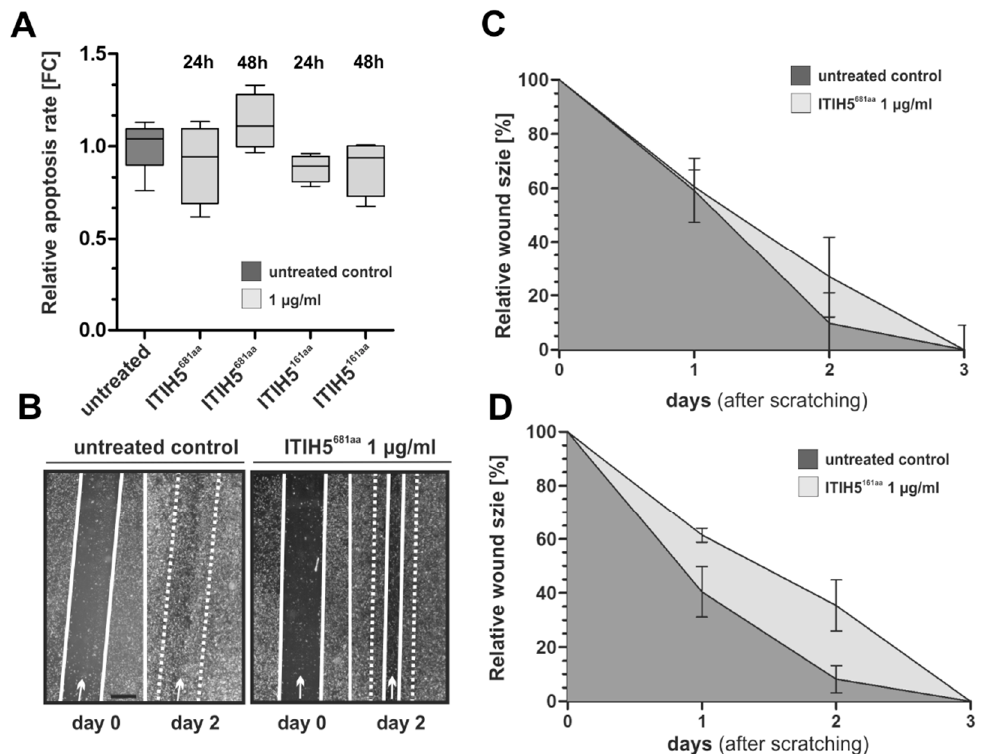
Figure 5. The impact of ITIH5 681aa and ITIH5 161aa treatment on the apoptosis and motile characteristics of MDA-MB-231 breast cancer cells. ( A ) Caspase 3/7 activity as an indicator of apoptosis in MDA-MB-231 cells either treated with ITIH5 681aa ( 1 µg/mL) or ITIH5 161aa (1 µg/mL) for 24 h and 48 h. The box plot shows the relative apoptosis rate. Horizontal lines: grouped medians. Boxes: 25–75% quartiles. Vertical lines: range, minimum and maximum. ( B – D ) Cell migration was analyzed by using a wound healing assay. ( B ) Representative wound area documentation by light microscopy 0 and 48 h after scratching. White line: cell-free wound area. White dashed line: original wound area size at 0 h. Original magnification 50 × . ( C , D ) The mean migration rate of an untreated (PBS) control cell set and MDA-MB-231 cells treated with either ( C ) ITIH5681aa (1 µ g/mL) or ( D ) ITIH5161aa (1 µg/mL) was analyzed over 3 days. Vertical lines: standard deviation (S.D.) of triplicates. The cell-free area on Day 0 was set as 100% and used for standardization.